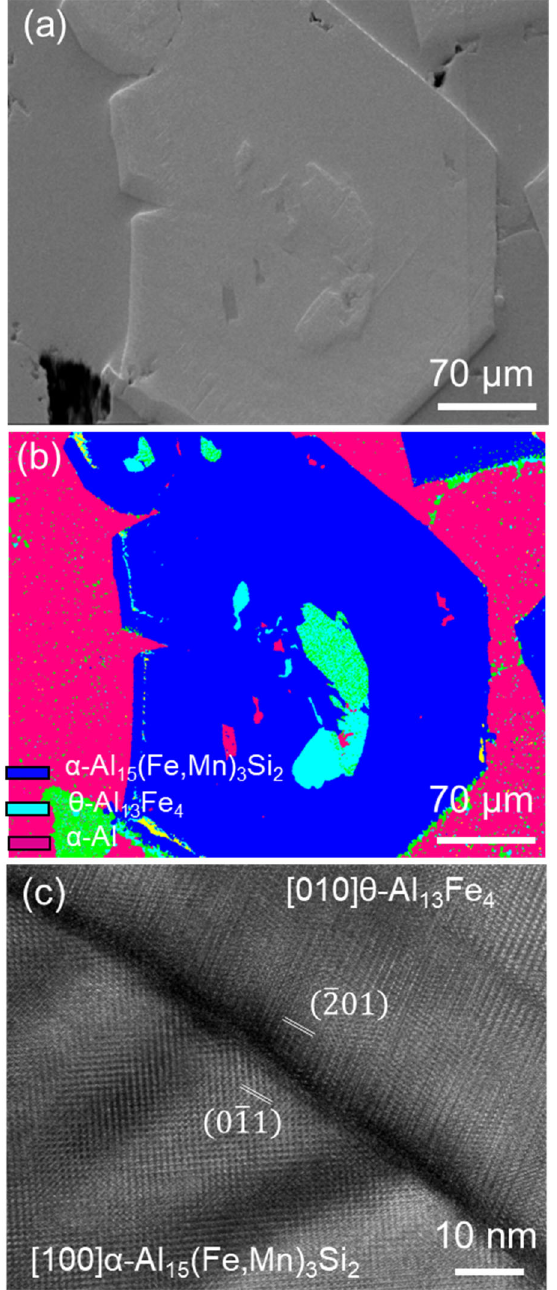
Figure 9. The non ‐ equilibrium primary θ‐ Al 13 Fe 4 (P ‐θ ) was formed first in the liquid, and the equi ‐ librium compact primary α‐ Al 15 (Fe, Mn) 3 Si 2 grows on the P ‐θ . [66] ( a ) SEM ‐ SEI image showing the α‐ Al 15 (Fe, Mn) 3 Si 2 particle with central θ‐ Al 13 Fe 4 in Al ‐ 5Mg ‐ 2Si ‐ 0.6Mn ‐ 1.3Fe alloy solidified at 0.01 K/s from a pouring temperature of 720 °C; ( b ) EBSD mapping identified θ‐ Al 13 Fe 4 and α‐ Al in α‐ Al 15 (Fe, Mn) 3 Si 2 particle; and ( c ) HRTEM image viewed along the [0 1 0] zone axis of θ‐ Al 13 Fe 4 and [1 0 0] zone axis of α‐ Al 15 (Fe, Mn) 3 Si 2 , showing the orientation relationship between θ‐ Al 13 Fe 4 and α‐ Al 15 (Fe, Mn) 3 Si 2 : (cid:3435) 2 0 1 (cid:3439) θ‐ Al 13 Fe 4 //2.3° (cid:3435) 0 1 1 (cid:3439) α‐ Al 15 (Fe, Mn) 3 Si 2 , and [0 1 0] θ‐ Al 13 Fe 4 //[1 0 0] α‐ Al 15 (Fe, Mn) 3 Si 2 . [66].